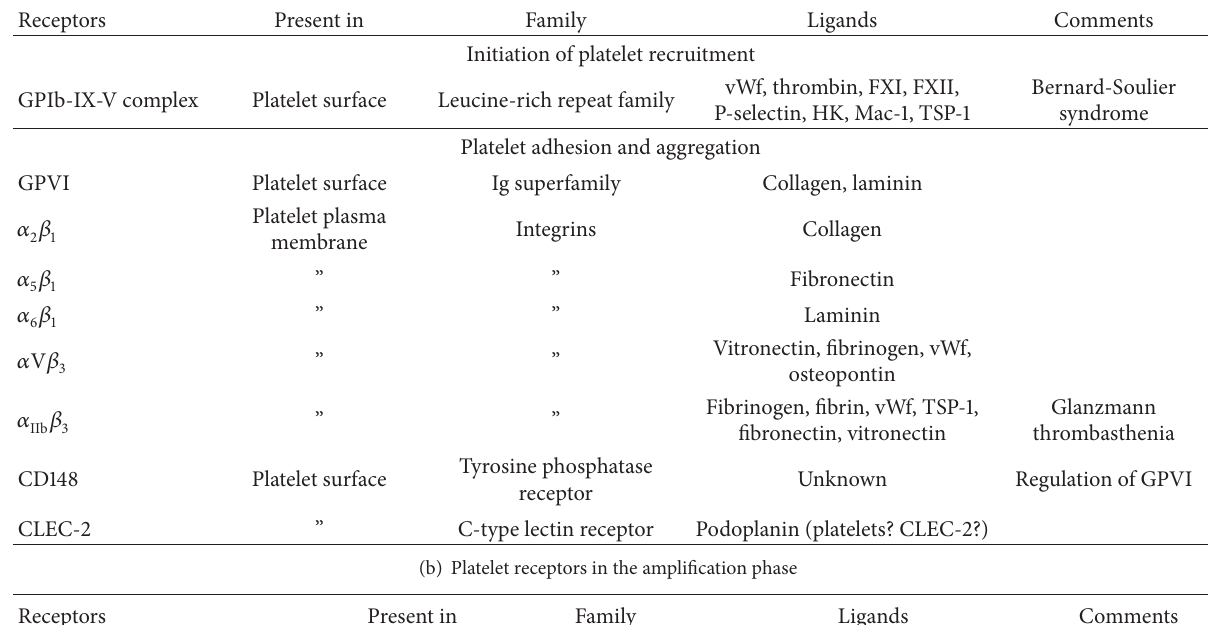
Table 1: Platelet receptors in different activation stages (adapted from Kauskot and Hoylaerts, 2012 [20]). (a) Platelet receptors in recruitment, adhesion, and